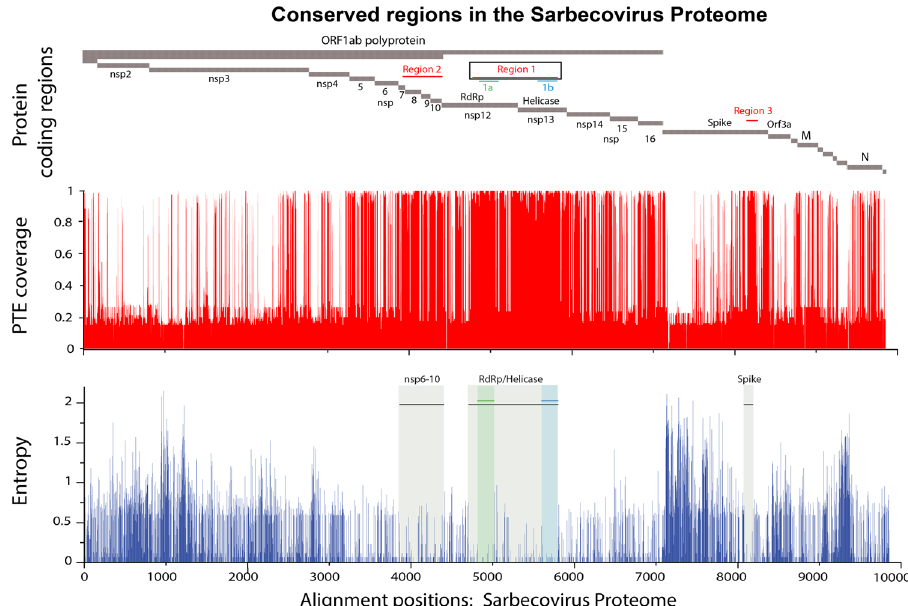
Fig. 1 Highly conserved regions identi fi ed between multiple sarbecoviruses from bats, pangolin, and human SARS-CoV and SARS-CoV-2. A multiple alignment of 82 sarbecoviruses were selected to capture diversity across the sarbecovirus proteome. The top part of the graph shows where the ORFs and protein coding regions are located within the proteome, the highlighted most conserved regions are labeled Region 1, 2 and 3; Regions 1a and 1b were exceptionally conserved within region 1. The Membrane (M) and Nucleocapsid (N) proteins are also labeled. PTE coverage relative of the aligned proteins by the SARS-CoV-2 Wuhan reference strain (Accession _NC_045512) is indicated in red; a value near 1 means that nearly all of the proteins in the alignment have a perfect match to the 9 amino acid long peptide (PTE) starting in a given position. 17% of the viruses were SARS-CoV-2, so a score of <0.2 indicates that the PTE in the reference strain is commonly matched only among SARS-CoV-2 viruses. Entropy scores for each position in the full proteome alignment are shown in blue in the bottom graph; in this case, lower scores indicate greater conservation, and Regions 1, 2 and 3, are indicated by the beige boxes in this plot, with the most highly conserved stretches highlighted in green and